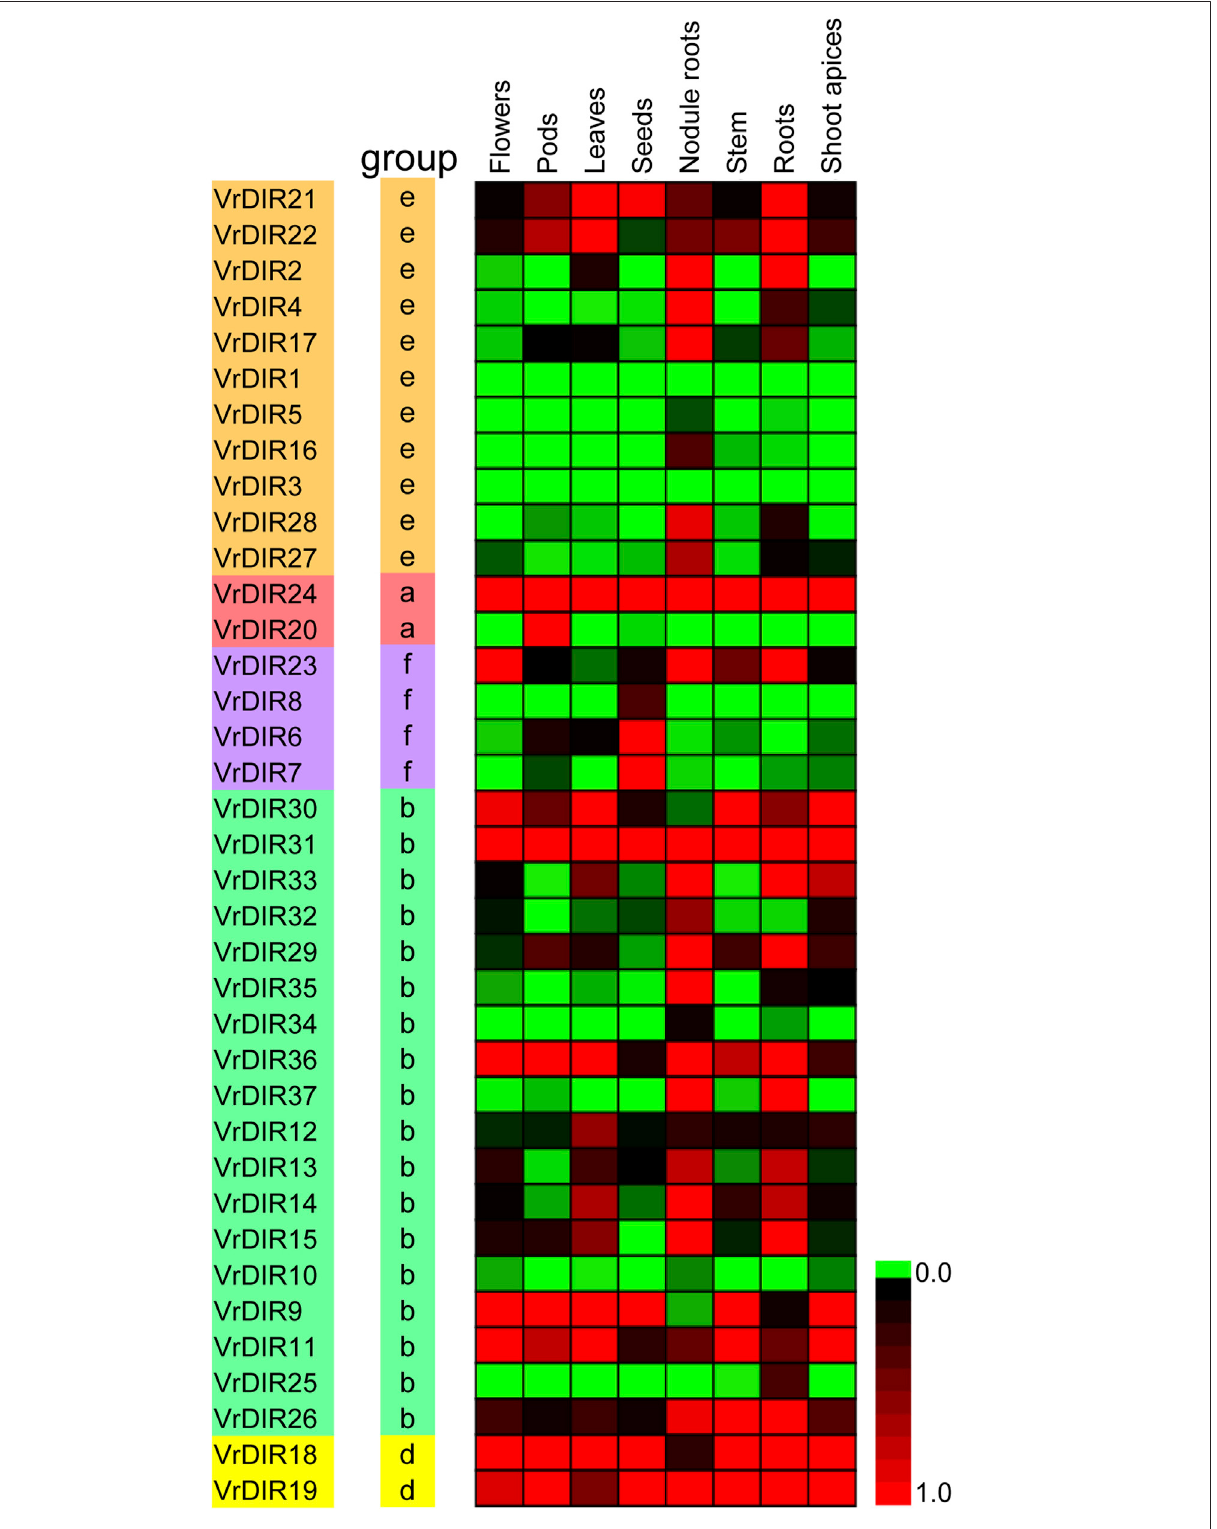
FIGURE 6 | Relative expression levels of VrDIR genes in different tissues. Eight tissues, including fl owers, pods, leaves, seeds, nodule roots, stems, roots, and shoot apices, were used for analysis. The expression level of VrDIR37 in nodule roots was set as one, and the others were adjusted accordingly. The gene expression results were visualized using a heatmap generated with Multiple Experiment Viewer 4.9.0 (Saeed et al., 2003). The expression levels from 0 to one are indicated by different colors.